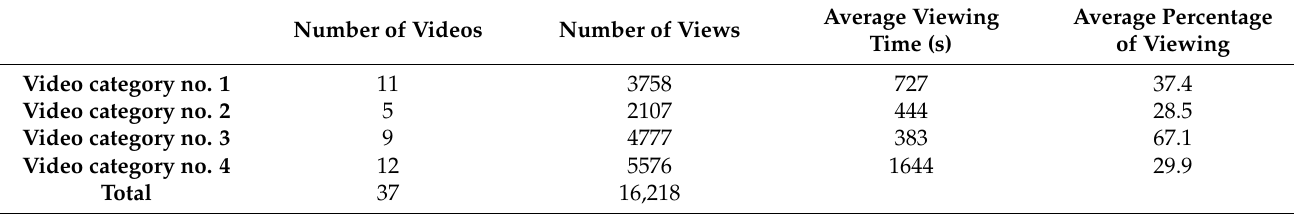
Table 2. Analysis of data from the “MCAD I UNIWA” YouTube channel. Number of Videos Number of Views